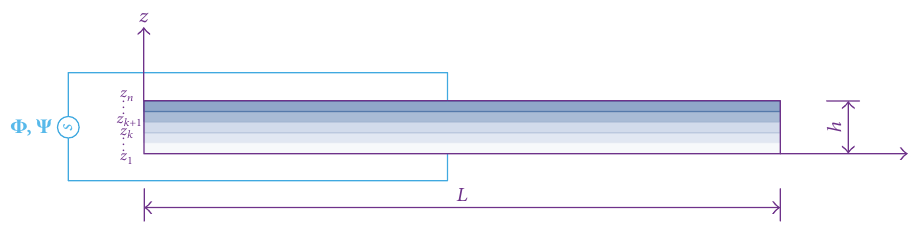
Figure 1: FGMEE beams: Cartesian coordinate system and geometric